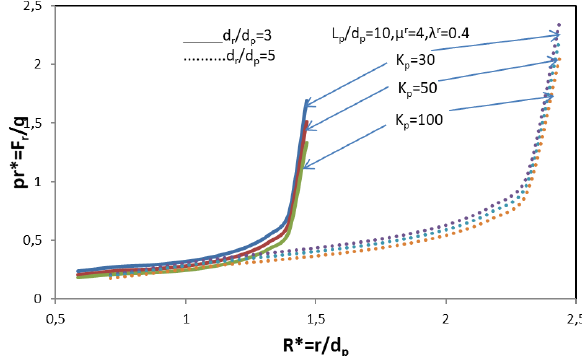
Figure 17: Variation of SIF for any depth, i z =z/L – effect of comparative length λ r of strengthening from top of 1 p GP on partially strengthened GP–raft foundation (L μ r =0.4).